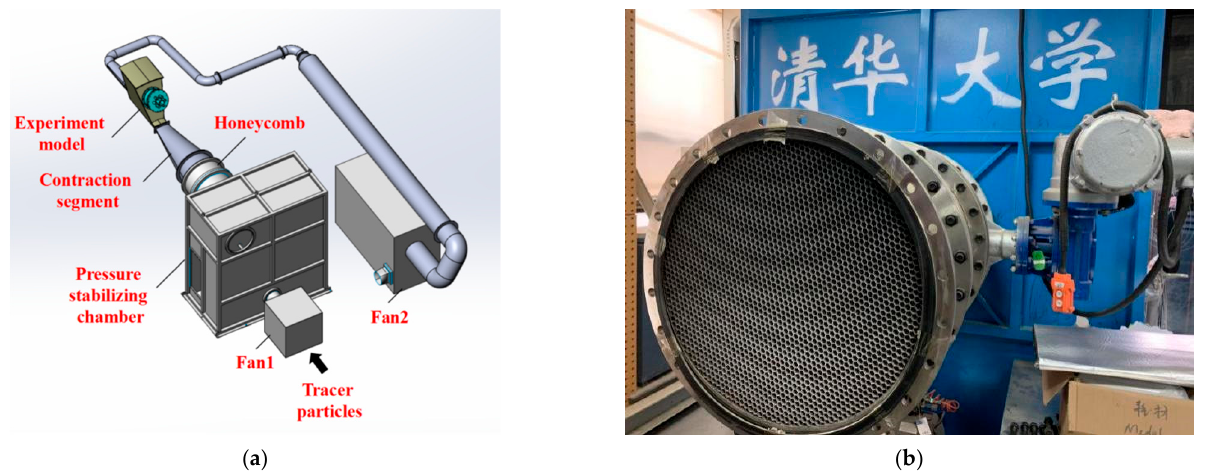
Figure 5. Air supply system. ( a ) 3-D schematic diagram; ( b ) Honeycomb.